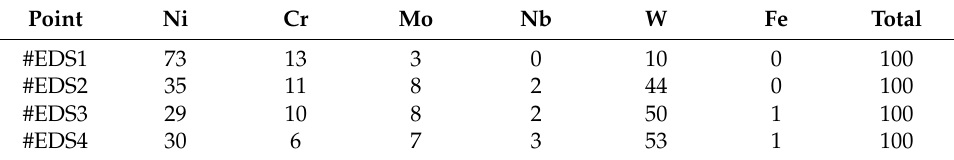
Figure 9. TEM images showing WC dissolution in the γ -Ni matrix: ( A ) bright-field image, ( B ) dark-field image, ( C ) diffraction pattern of WC with [-4311] crystallographic orientation, ( D – F ) diffraction pattern of γ -Ni grains with [-112], [-113], [-114] crystallographic orientation. Table 2. TEM-EDS point analysis in areas shown in Figure